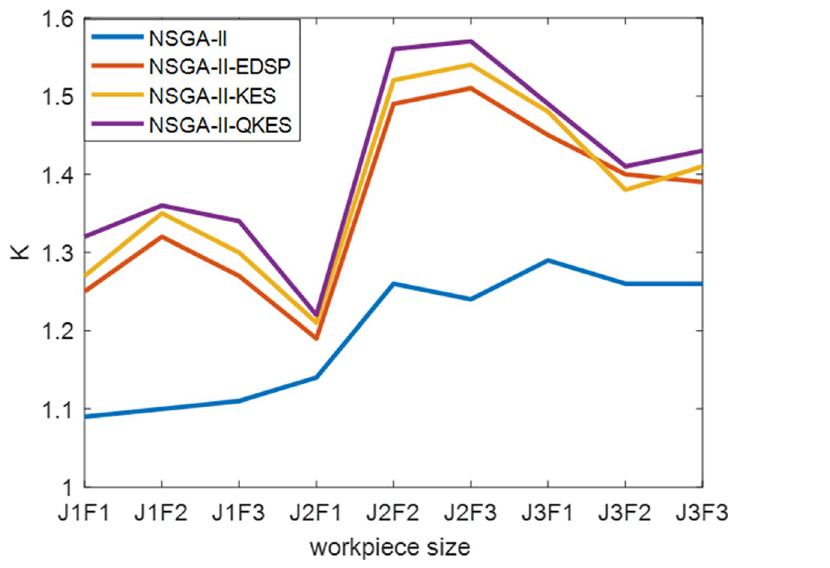
Fig 4. Algorithm comparison chart.